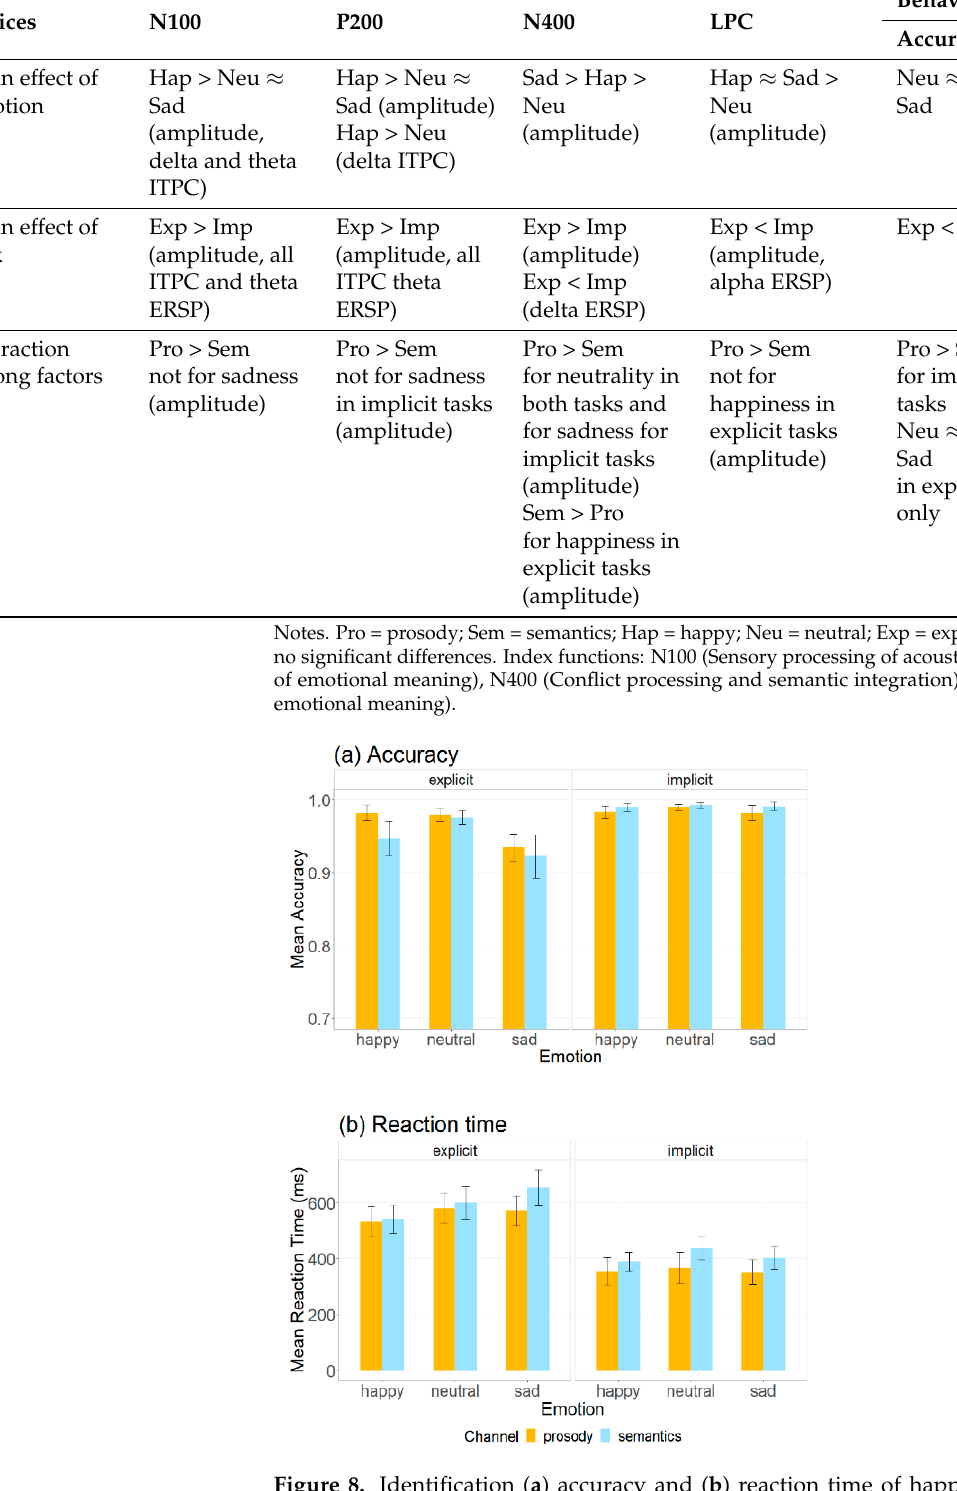
Figure 8. Identification ( a ) accuracy and ( b ) reaction time of happy, neutral and sad stimuli in prosodic and semantic channels across explicit and implicit tasks. Mean accuracy is displayed in the bar charts with error bars showing 95% confidence intervals.